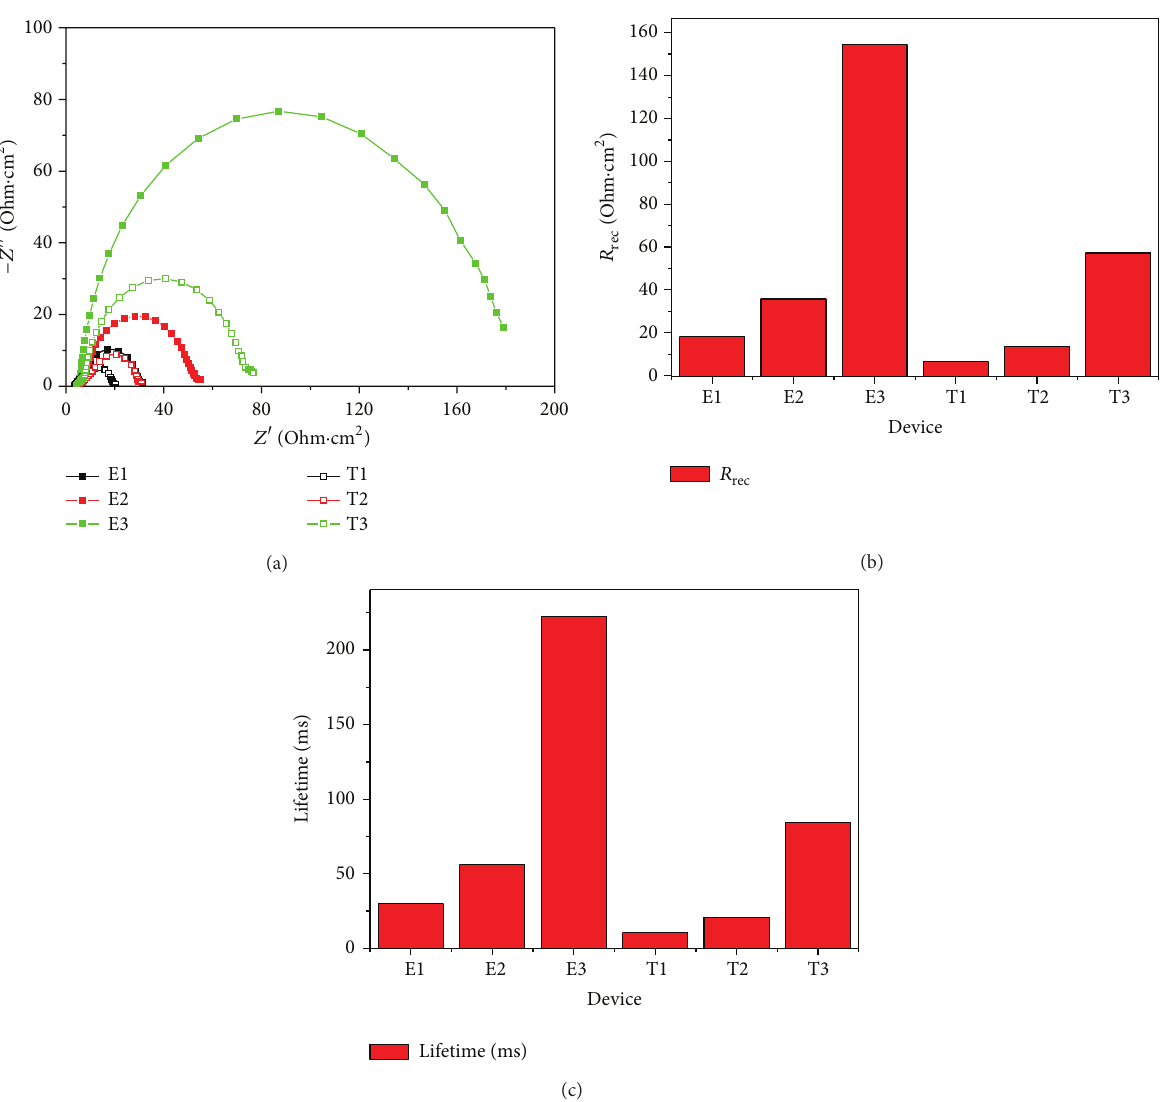
Figure 4: (a) Electrochemical impedance spectra (Nyquist plots) applied voltage is 0.65 V under dark condition, (b) recombination resistance ), and (c) lifetime for the DSSCs using EtOH and THF as a dye bath solvent, ( 𝑅 rec